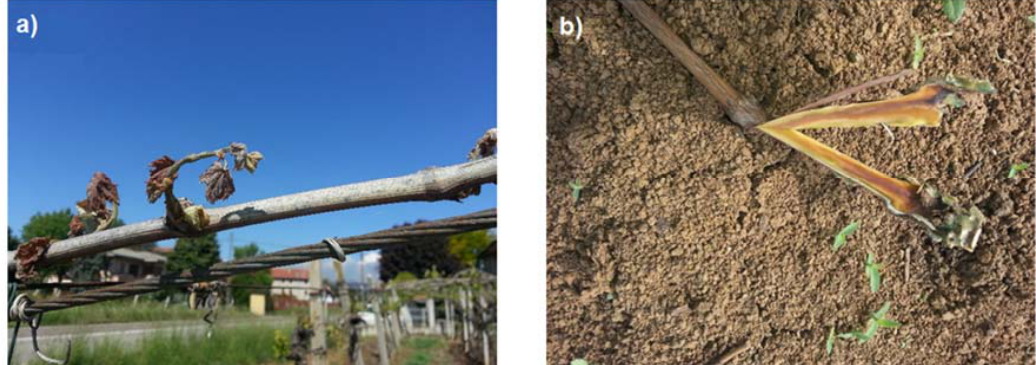
Figure 3. Frost damage affected both ( a ) green and ( b ) woody tissues.